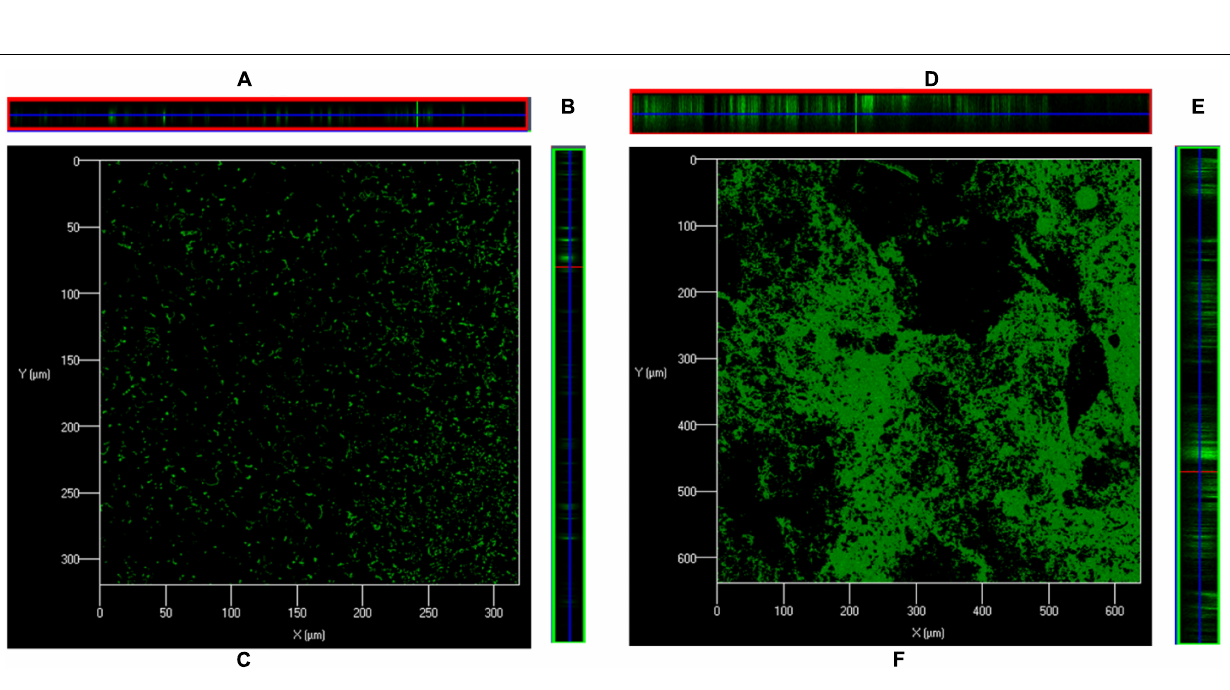
FIGURE 3 | Confocal microscopy images of S. pneumoniae D39 in vitro biofilms grown in metal ion-free medium for 48 h. (A) Is XZ and (B) is YZ plane, and (C) is 3-D confocal microscopy image of the S. pneumoniae biofilm grown without ASD (control). (D) Is XZ and (E) is YZ plane, and (F) is 3-D confocal microscopy image of the S. pneumoniae biofilm grown with ASD (300 µ